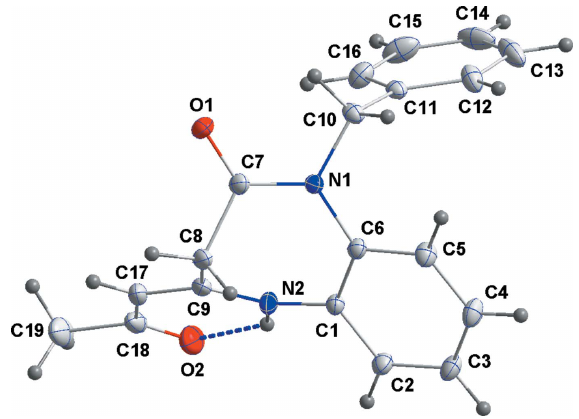
Figure 1 The title molecule with the labelling scheme and 50% probability ellipsoids. The intramolecular N—H (cid:2)(cid:2)(cid:2) O hydrogen bond is shown as a dashed line.